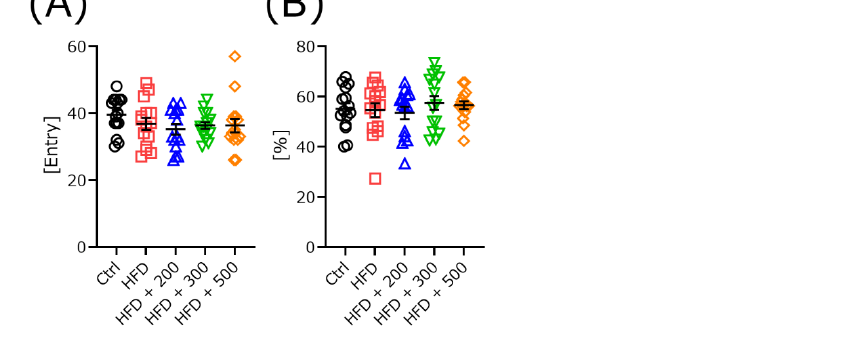
Figure 3. Total arm entries ( A ) and alternation scores ( B ) were measured using the Y-maze test. Control (Ctrl, n = 15), high-fat diet (HFD, n = 15), HFD + DSW-extract-added water hardness 200 (HFD + 200, n = 15), HFD + DSW-extract-added water hardness 300 (HFD + 300, n = 15), HFD + DSW-extract-added water hardness 500 (HFD + 500, n = 15). The data are shown as means ± SE. Comparisons were performed using the Tukey-Kramer method.